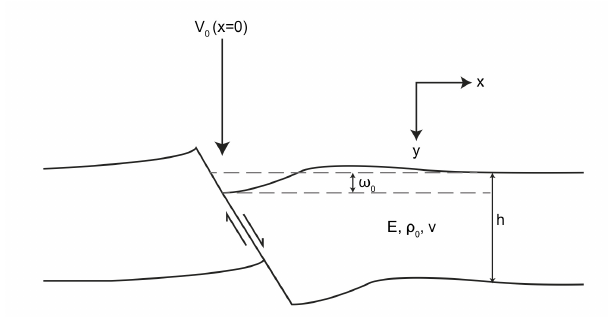
Figure A3. Set-up for hanging wall deflection equations. A vertical load ( V 0 ) is applied to the point where the hanging wall intersects the surface (i.e. where x = 0) and where there is a maximum de- flection ( ω 0 ). The elastic thickness, Young’s modulus, density, and Poisson’s ratio of the crust are represented by h , E , ρ 0 , and v , re-